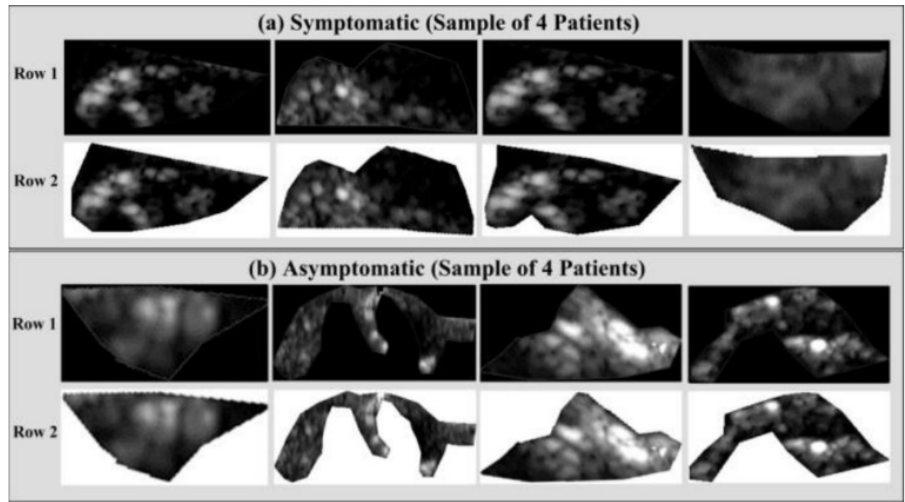
Figure 18. Delineated plaque in B ‐ mode US: ( a ) symptomatic plaque and ( b ) asymptomatic plaque (Courtesy of Atheropoint TM , Roseville, CA, USA) [44]. (Courtesy of Atheropoint TM , Roseville, CA, USA)